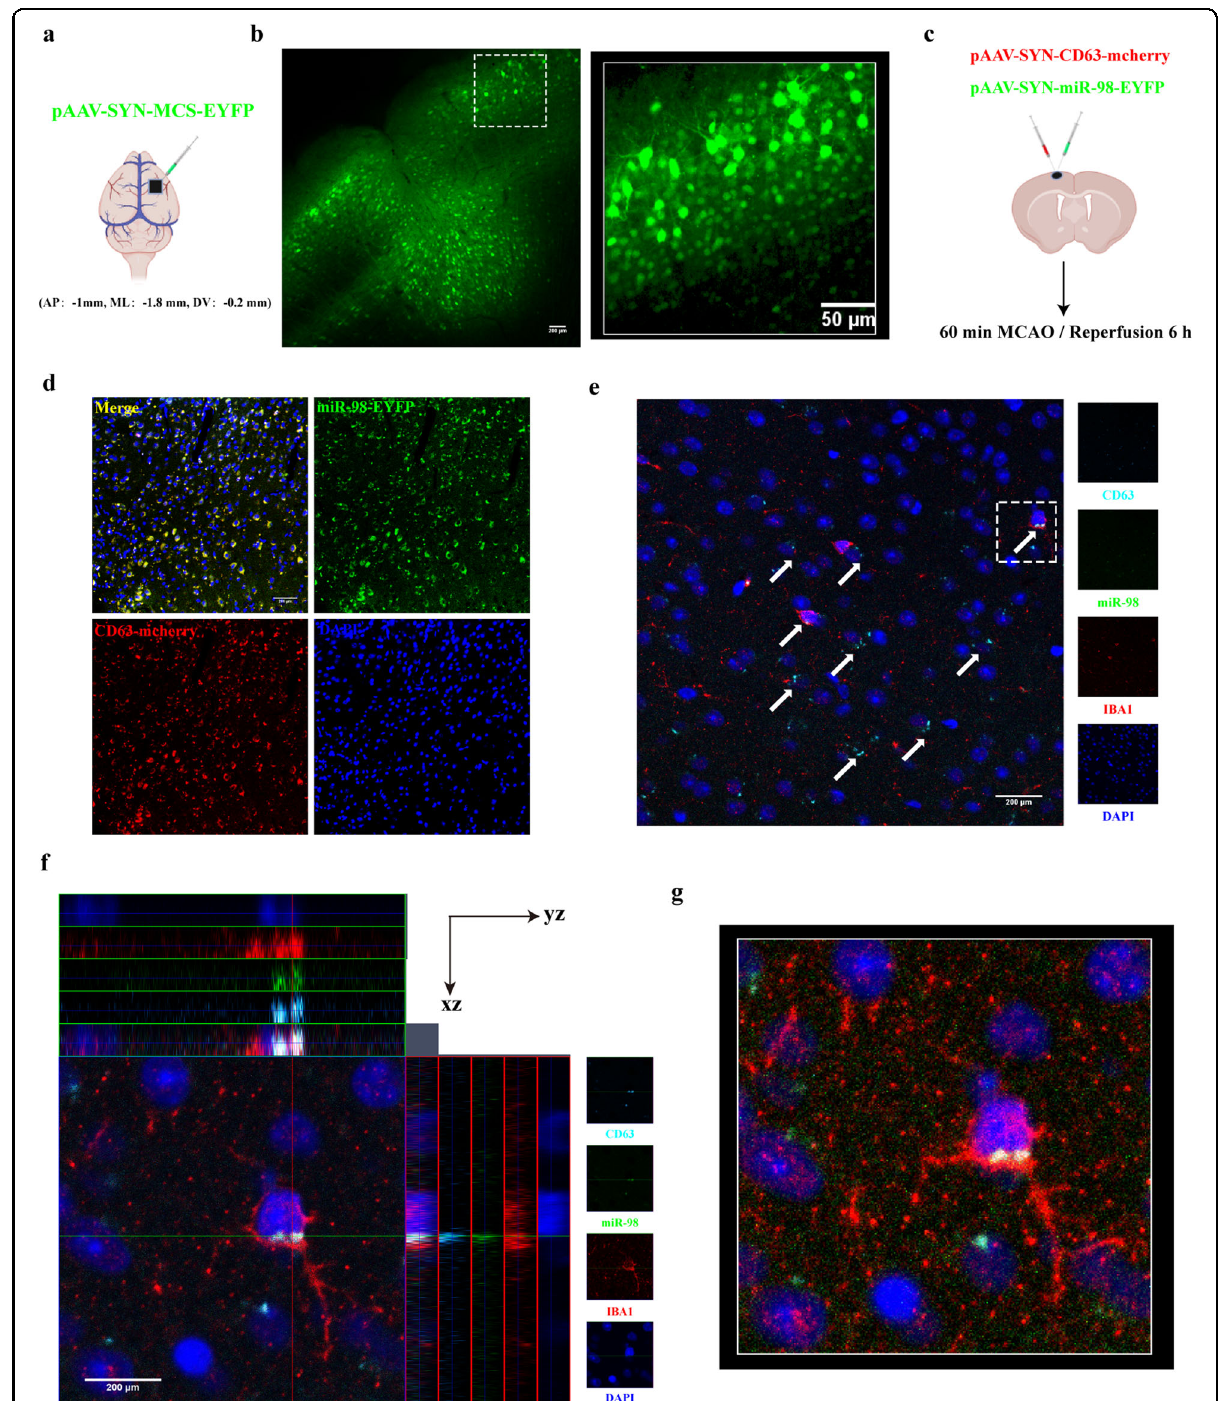
Fig. 3 In situ illustration of neuronal EVs derived miR-98 internalized into microglia after ischemic stroke. a The injection of control virus pAAV-SYN- MCS-EYFP-3FLAG (9.46×10 12 , 0.5 μ L) into cortex of P20 C57BL/6J mice (AP:-1mm, ML:-1.8mm, DV:-0.2mm). b The identi fi cation of the region and ef fi ciency of virus infection (left, Scale bar = 200 μ m) and the 3D reconstructions of Z-stack images in white dotted box acquired by a two-photon Microscope (right, 100 μ m thickness). c pAAV-SYN-CD63-mCherry-3FLAG (1.81×10 13 , 0.3 μ L) and pAAV-SYN-EYFP-3FLAG-miR-98 (8.36×10 12 , 0.3 μ L) were simultaneously injected into the same coordinates of control virus and subsequent tMCAO model 3 weeks later. d The representative confocal images of CD63-mCherry co- labeled with miR-98-EYFP and DAPI on paraf fi n slices (5 μ m thickness, Scale bar = 200 μ m). e – g The representative confocal images, ampli fi cation in white dotted box and colocalization analysis, and 3D reconstructions of CD63-mCherry co-labeled with miR-98-EYFP and IBA1 on paraf fi n slices 6h after ischemic stroke acquired by a confocal microscopy. (5 μ m thickness, Scale bar = 200 μ m) ( n = 3 independent experiments). The white arrows represent the CD63- mCherry and miR-98-EYFP were